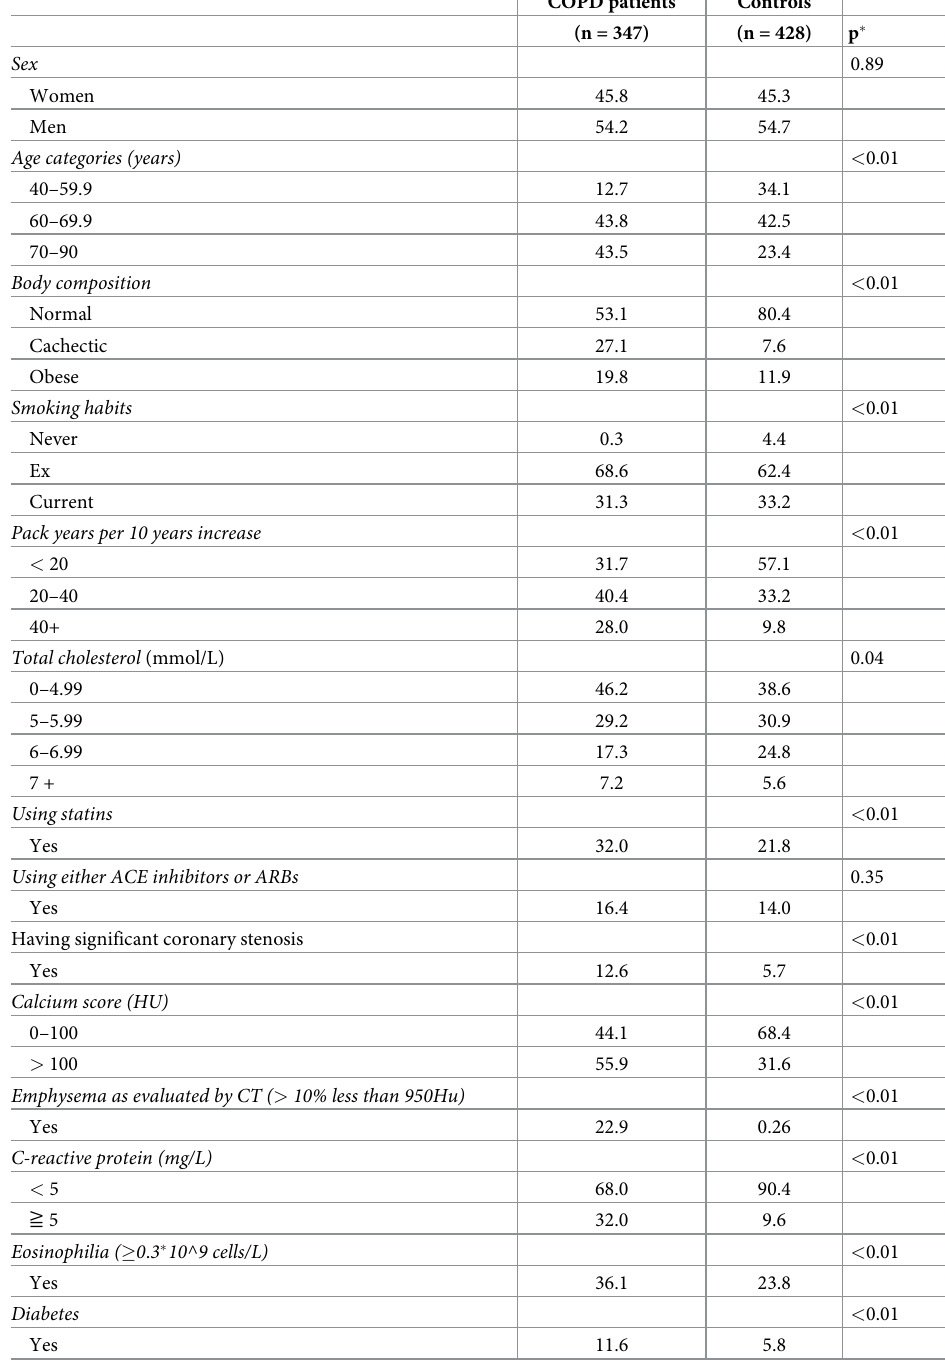
Table 2. Baseline characteristics of the study population in